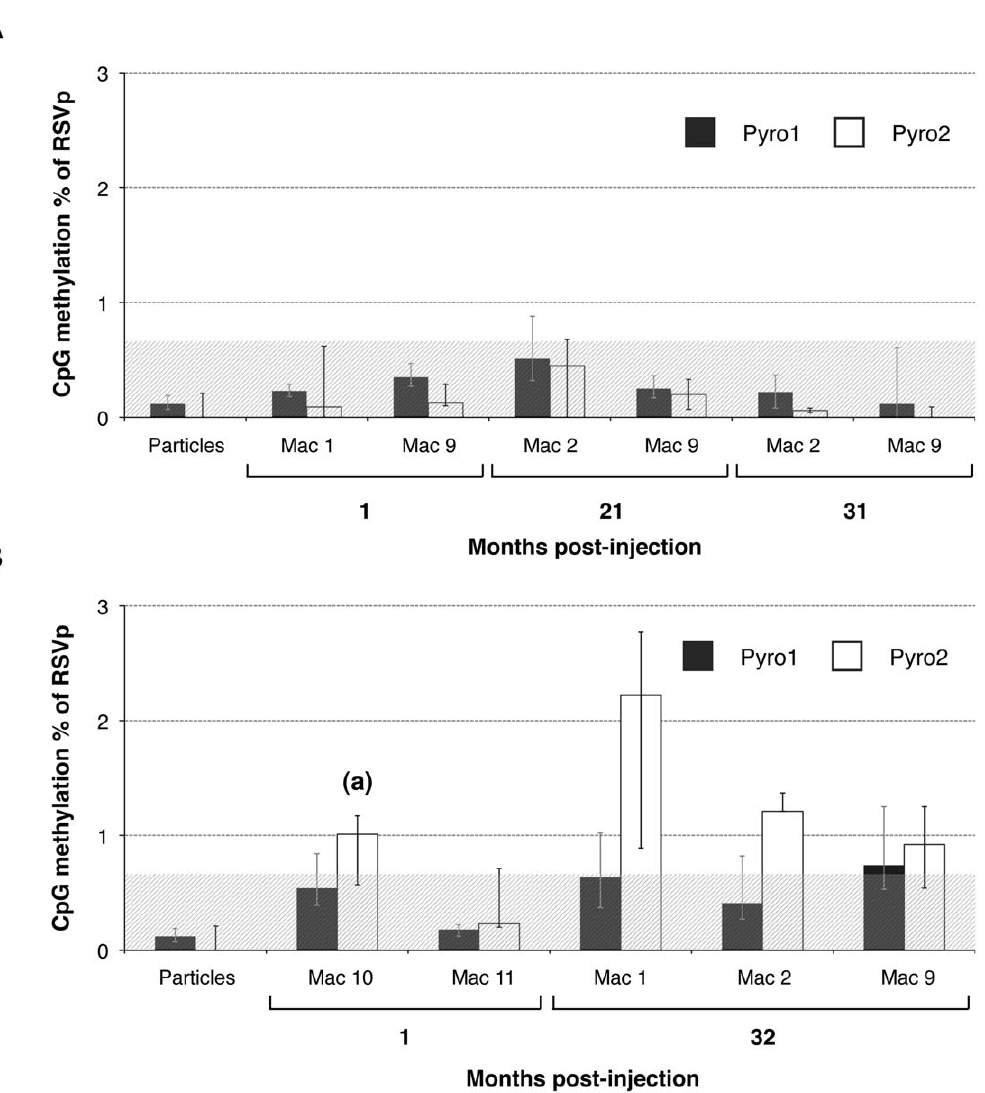
Figure 4. CpG methylation percentage of the RSVp after rAAV administration in NHP determined by high-throughput sequencing. NHP were injected IM (Mac 1, Mac 2, and Mac 9) or IV (Mac 10 and Mac 11) with the rAAV2/1-RSV-LEA29Y-WPRE-pA vector. Each animal received a dose of 5.10 12 vg/kg. Total DNA was extracted from transduced skeletal muscle (A) and liver (B) and subjected to a sodium bisulfite conversion and subsequent PCR amplification. 454 sequencing was performed to evaluate the Pyro1- and Pyro2-region methylation. (a) Bioinformatic analysis of this sample revealed some sequences for which all the CpGs were methylated. ( *** ) p value , 0.001.